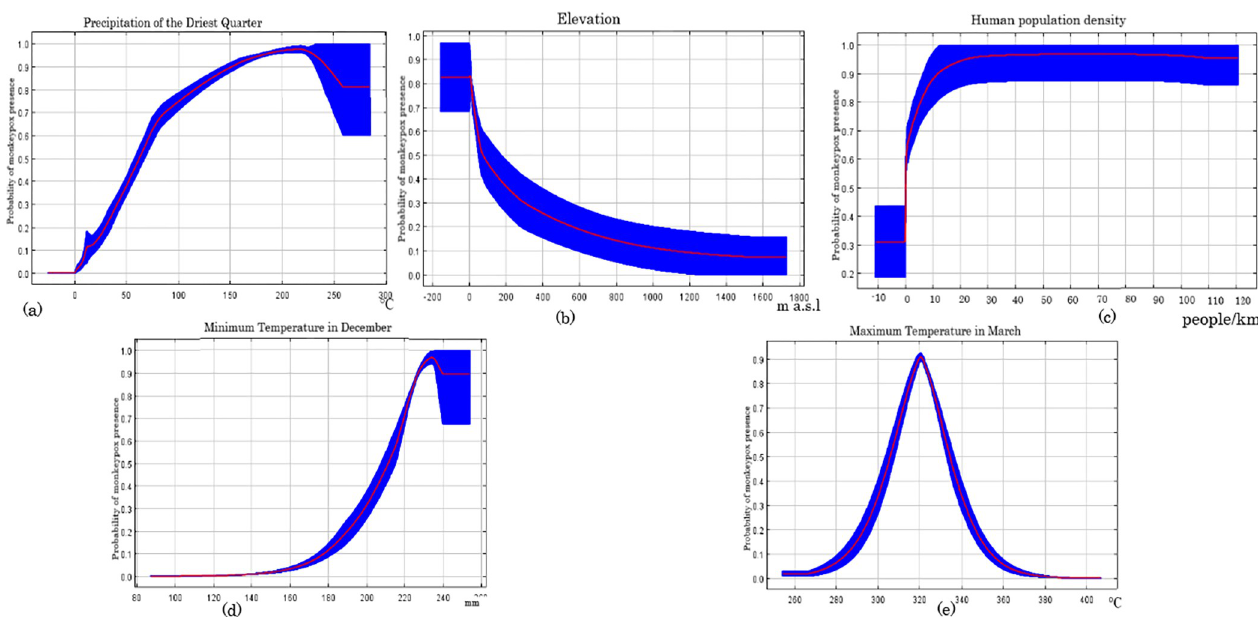
Fig 3. Response curves of predictive continuous variables ((a) precipitation of driest quarter, (b) elevation, (c) human population density, (d) minimum temperature in December, and (e) maximum temperature in March) for monkey pox suitability in southern Nigeria. The red lines indicate the mean values while the blue lines denote the standard deviation.